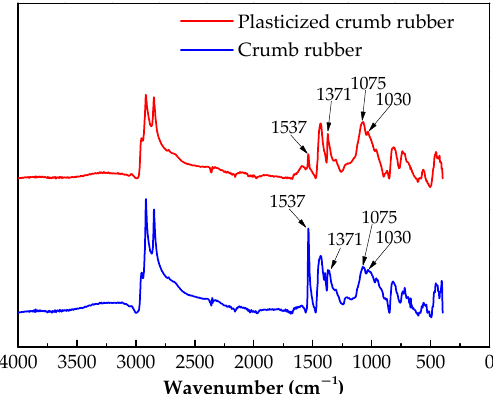
Figure 3. FTIR spectra of the untreated and plasticized crumb rubbers.